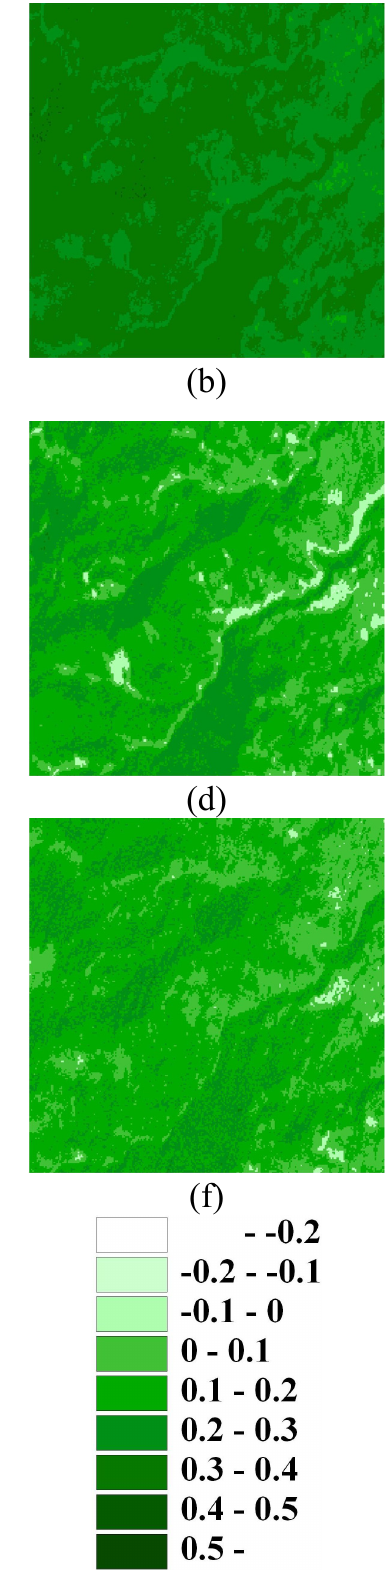
Figure 2. NDVI images of the area on (a) 1996/11/08, (b) 1999/03/06, (c) 1999/10/31, (d) 2000/11/27, (e) 2001/11/20, (f) 2003/12/17, and (g)